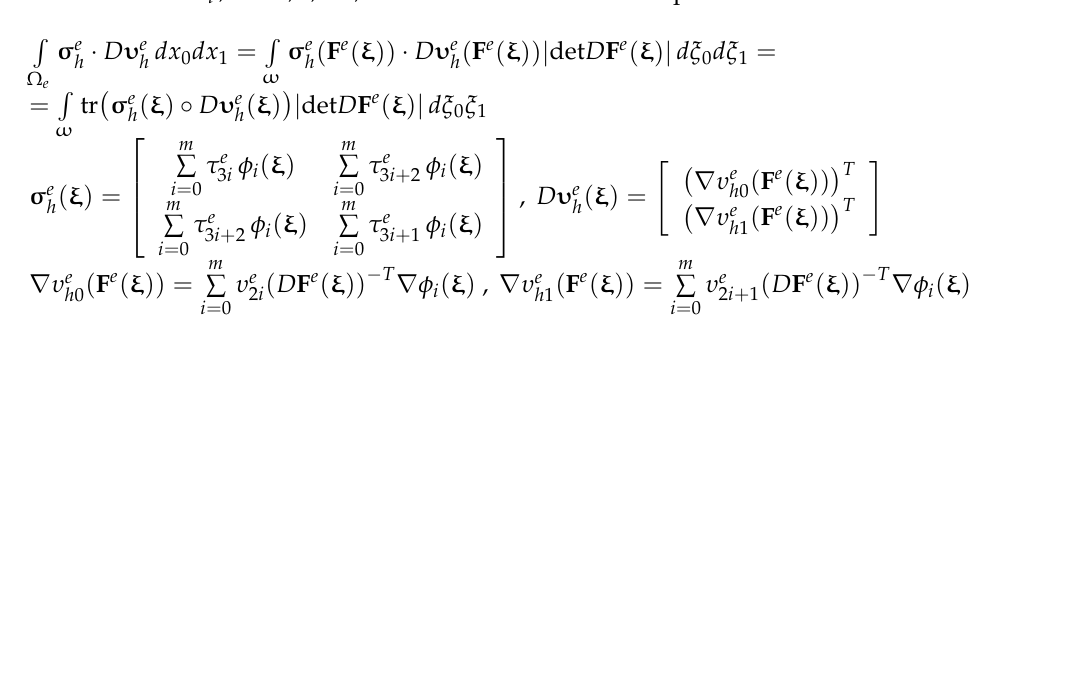
Figure 4. Notation of traction forces applied to all three (or four) edges Γ e of finite elements.